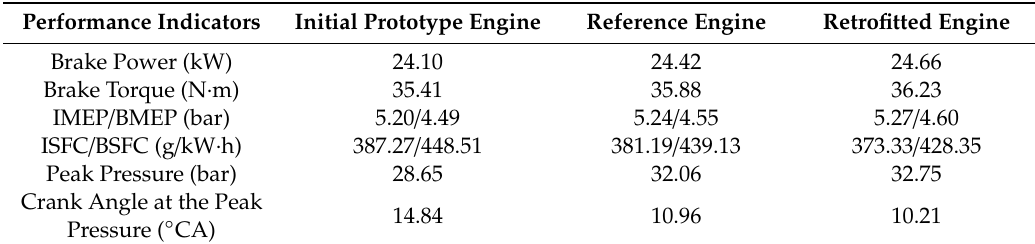
Table 23. Comparative simulation results of the full load operation condition (heavy